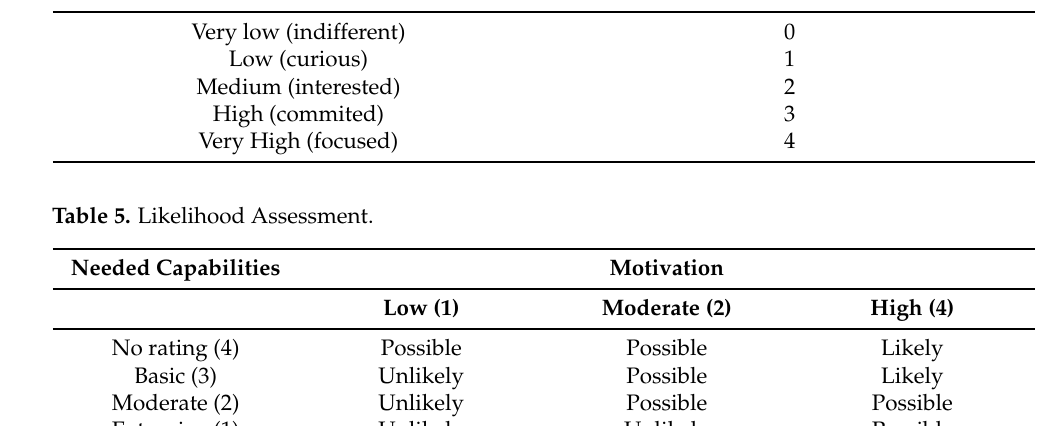
Table 4. Motivation.